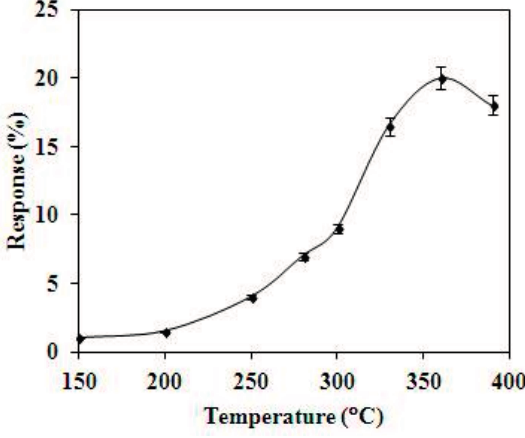
Figure 11. Response of the methanol sensor at 2 ppm